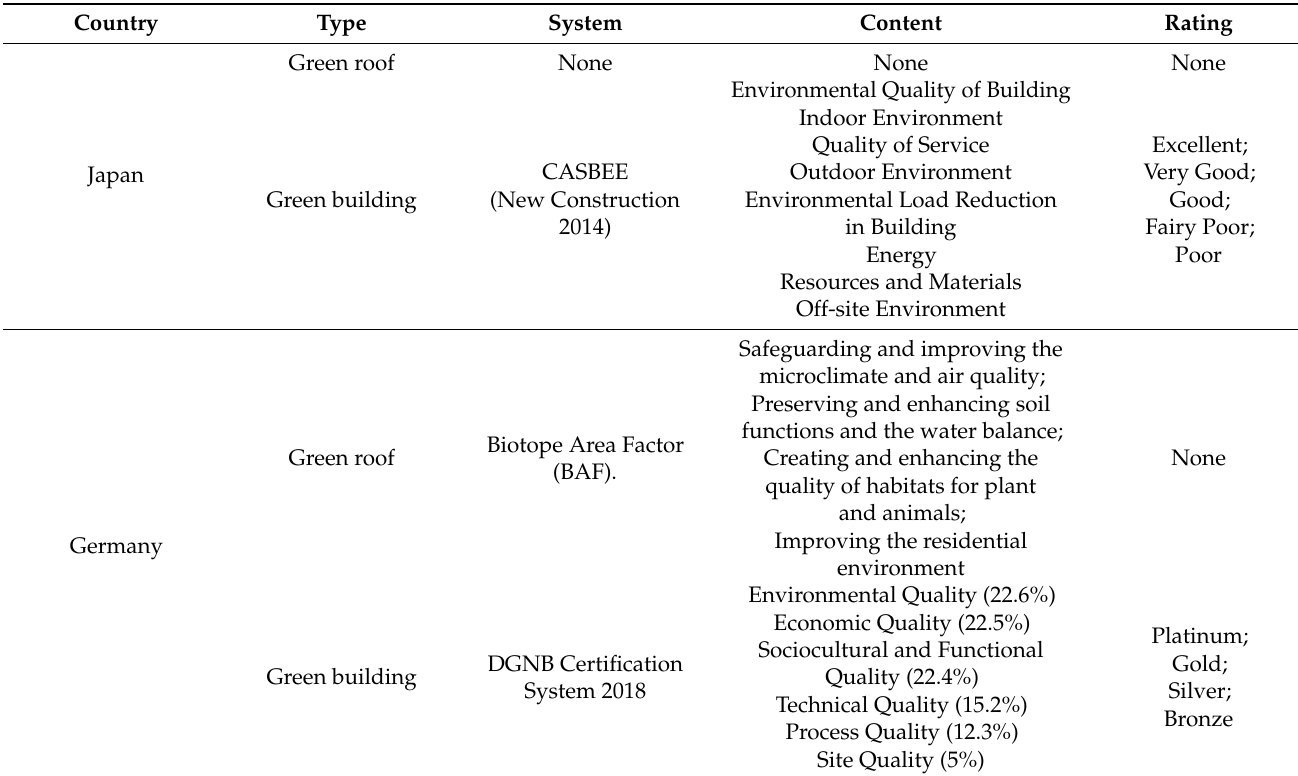
Table A3. Comparison of assessment or rating systems encouraging the construction of green roofs and green